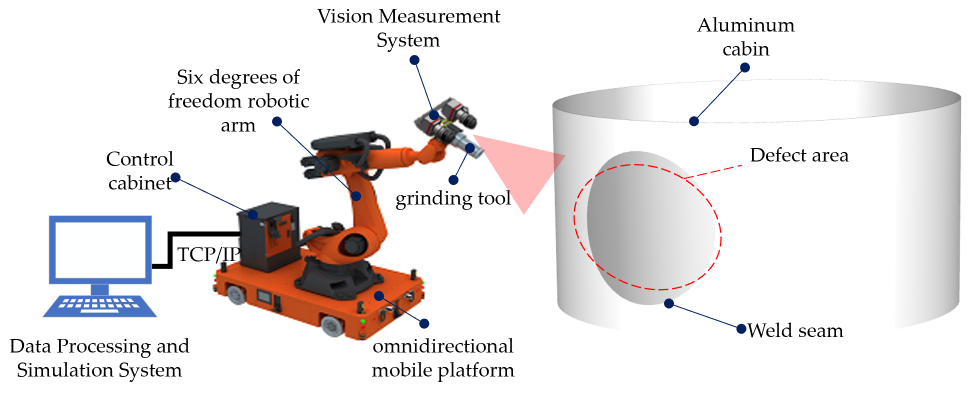
Figure 1. Schematic diagram of large aluminum alloy cabin